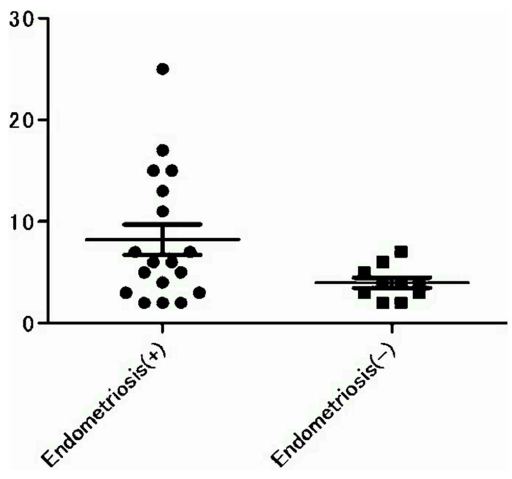
Figure 2. The number of accumulated immunoreactive cells in one HPF. All cases with over 11 plasma cells in one HPF belong to